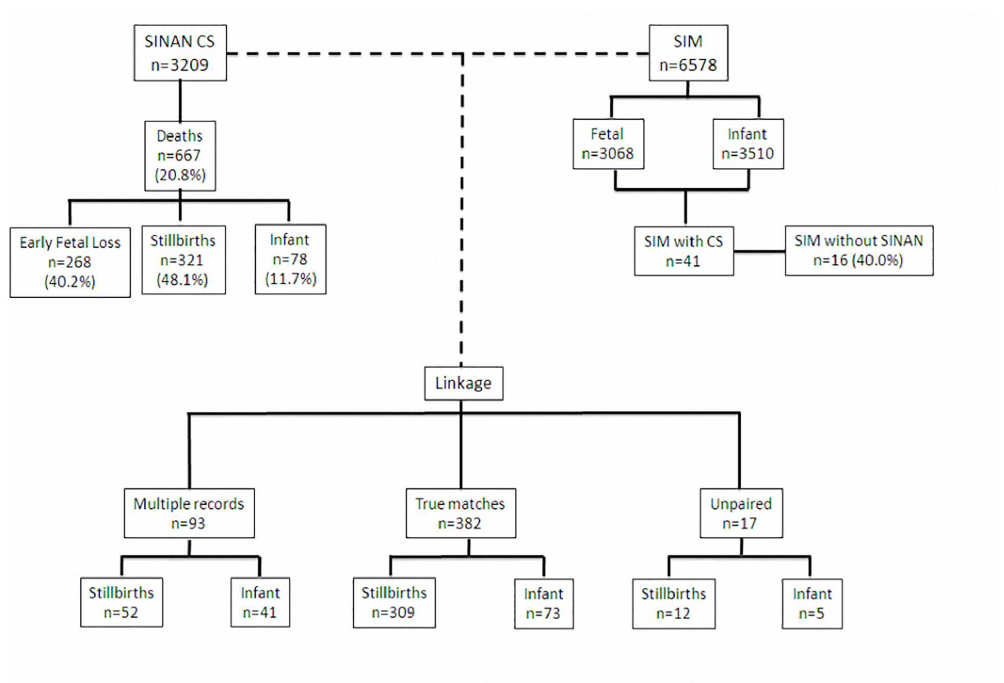
Fig 1. Deterministic record linkage between the Sistema de Informac¸ ã o de Agravos de Notificac¸ ã o (Sinan)- Congenital Syphilis and Sistema de Informac¸ ã o sobre Mortalidade (SIM) databases. Fortaleza, Northeastern, Brazil, 2007–2012.